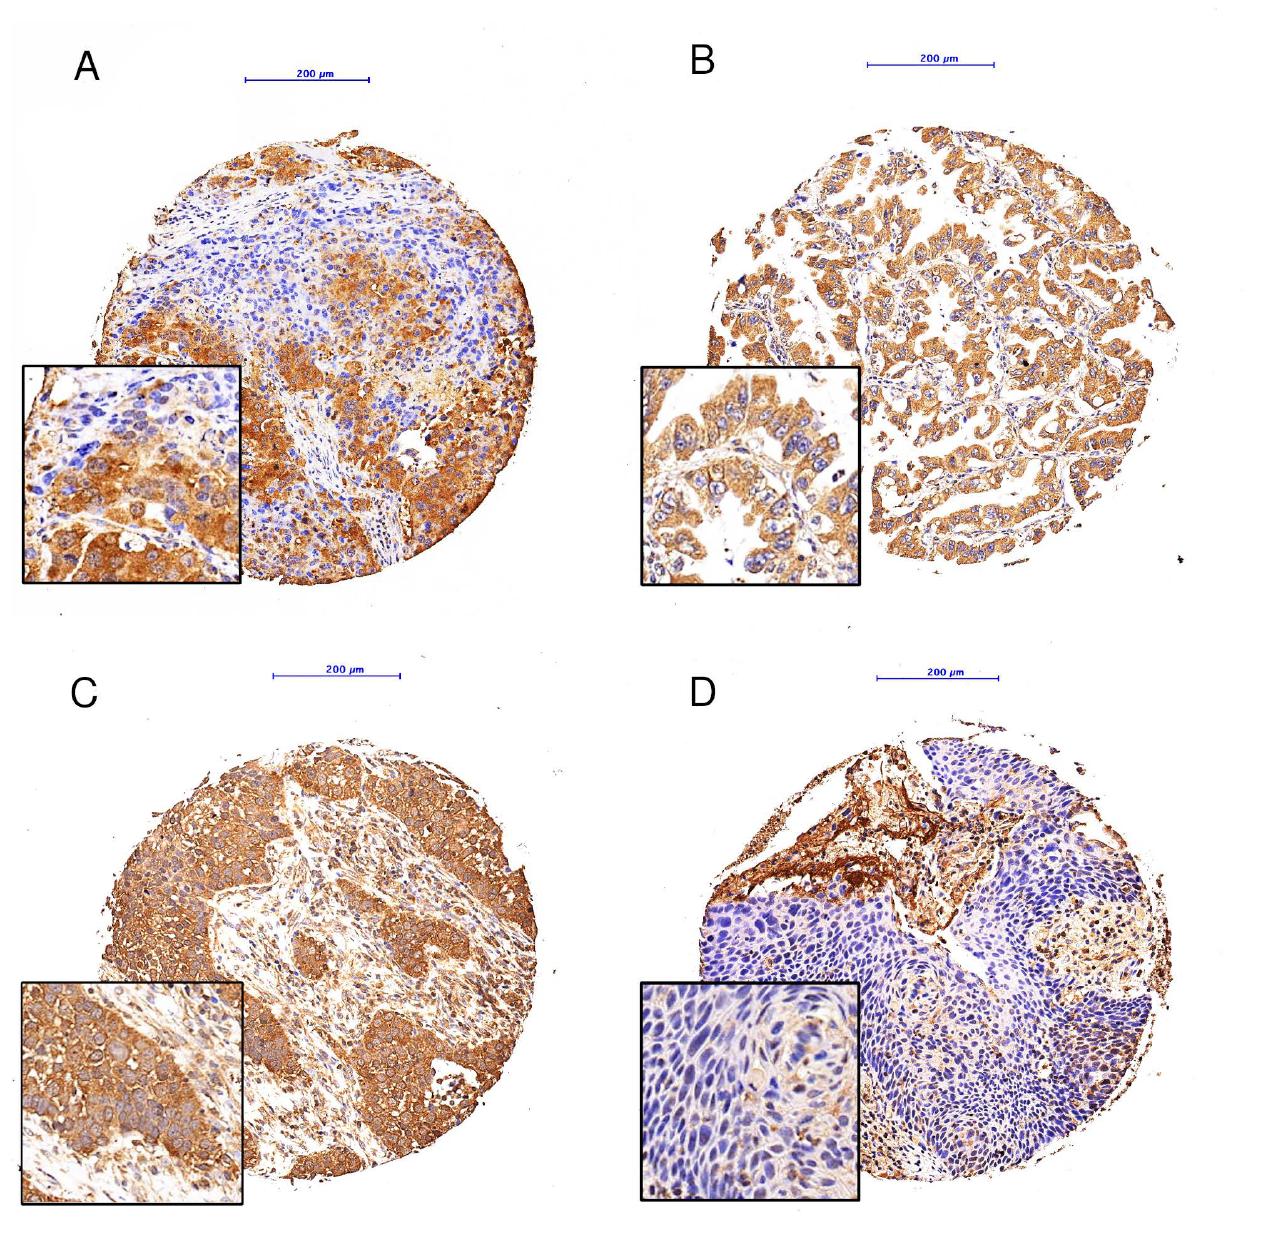
Figure 3. HSPA8, examples of immunohistochemical staining: ( A ): Adenocarcinoma, IRS 3 × 3 = 9; ( B ) Adenocarcinoma, IRS 2 × 4 = 8; ( C ): Squamous cell carcinoma, IRS 2 × 4 = 8; ( D ): Squamous cell carcinoma, IRS 0 × 4 = 0; Objective magnification: 10 × , Scale bar: 200 µ